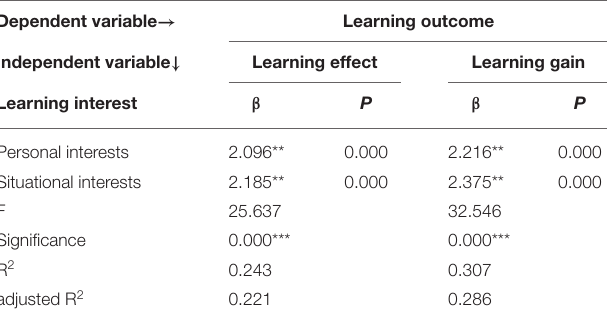
TABLE 3 | Analysis of the effect of learning interest on learning outcome. Dependent variable